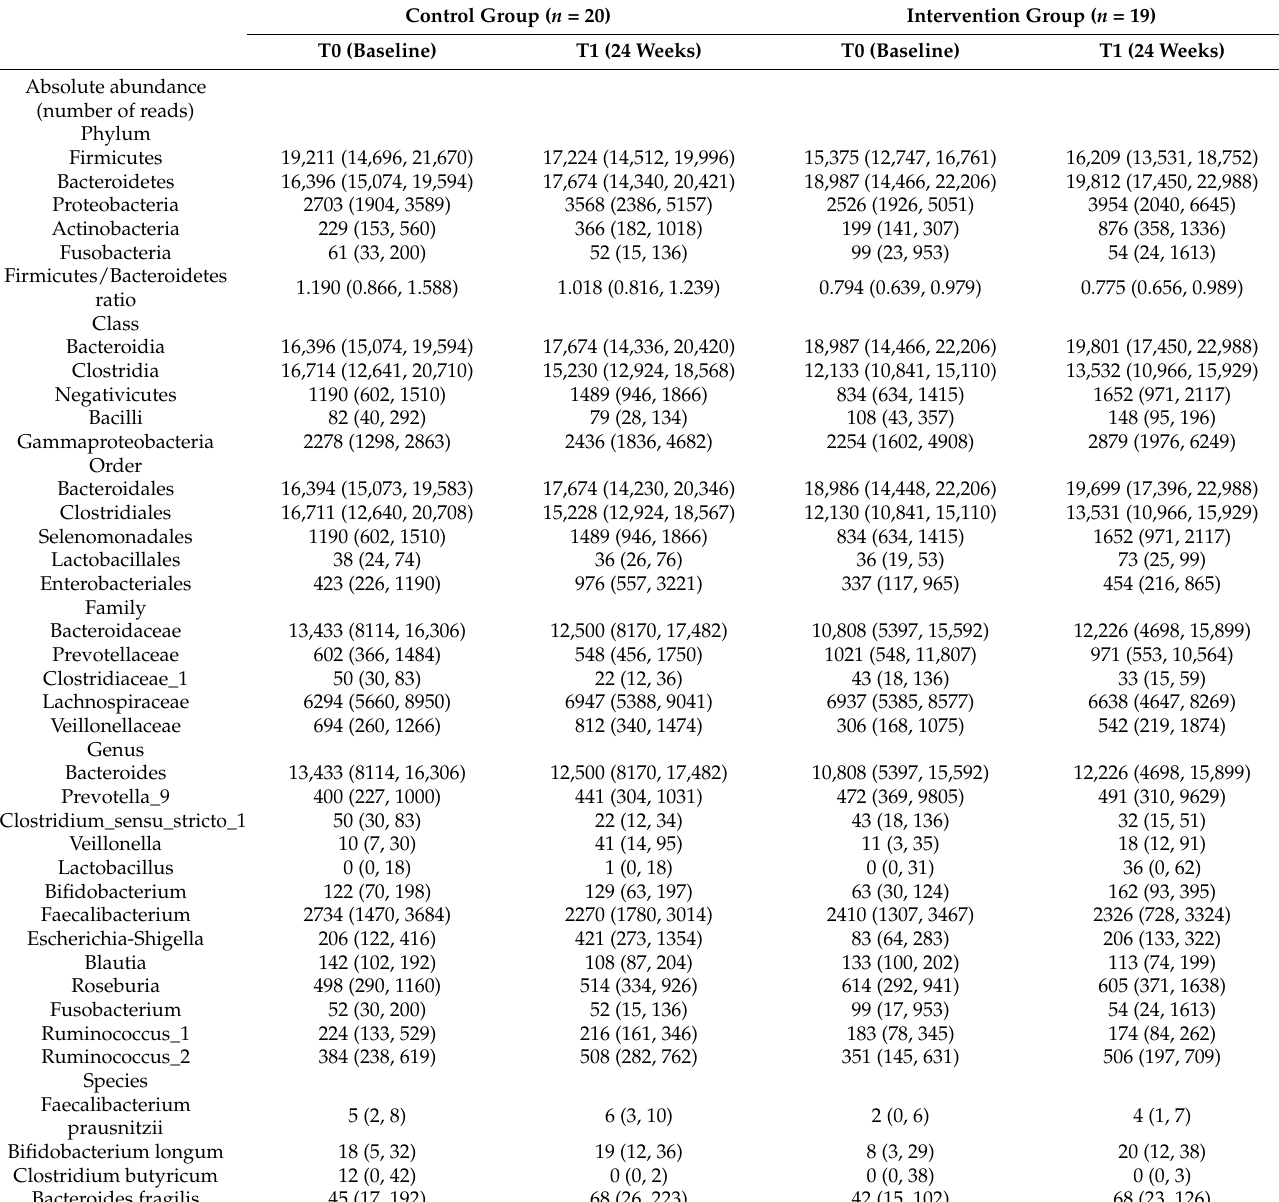
Table 3. Absolute abundance values indicating the faecal abundance of bacteria in various taxonomic levels at T0 and T1 among the control and intervention